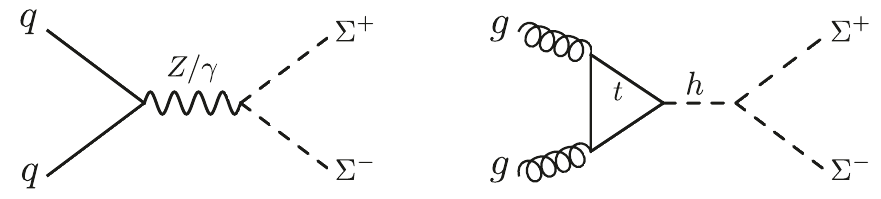
Figure 2 . Examples of production mechanisms of the charged scalars: the DY (left) and ggF (right)